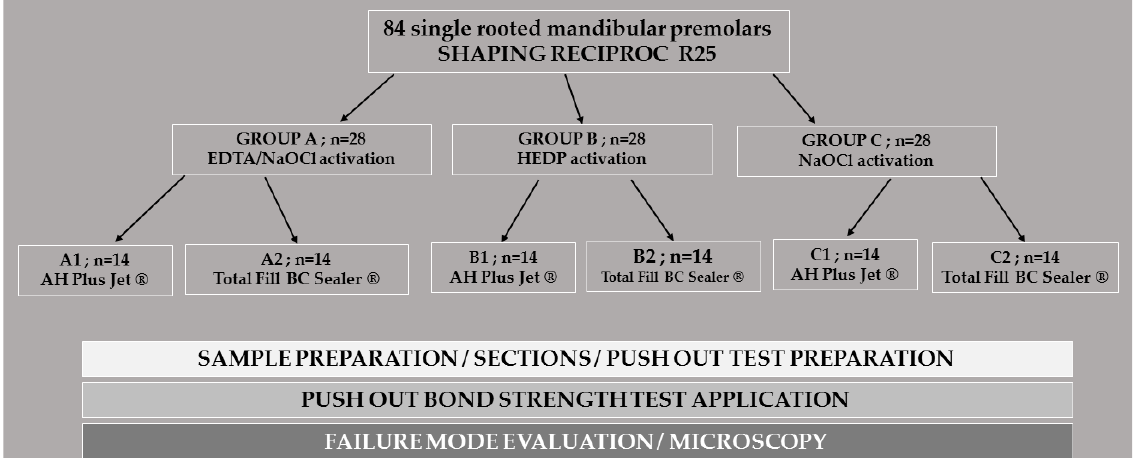
Figure 1. Schematic drawing of flow of the methodology performed for the present study.